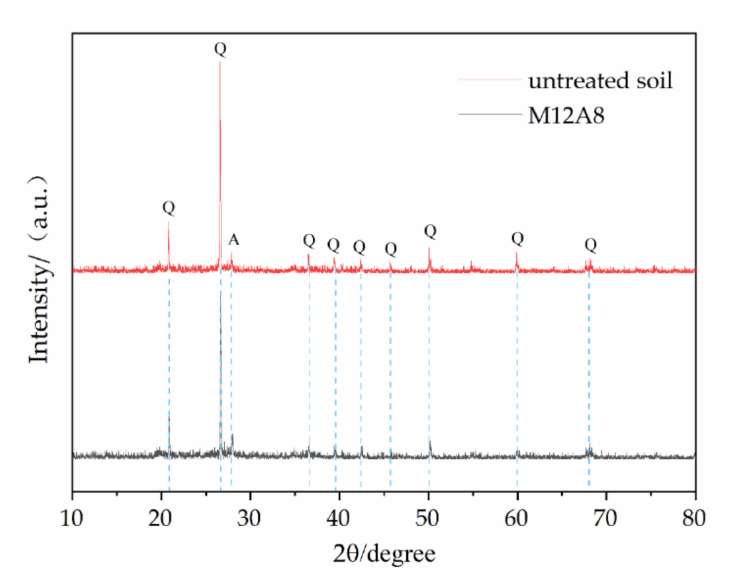
Figure 7. XRD patterns of Untreated soil and M12A8. Mineral abbreviations: Q: quartz; A: